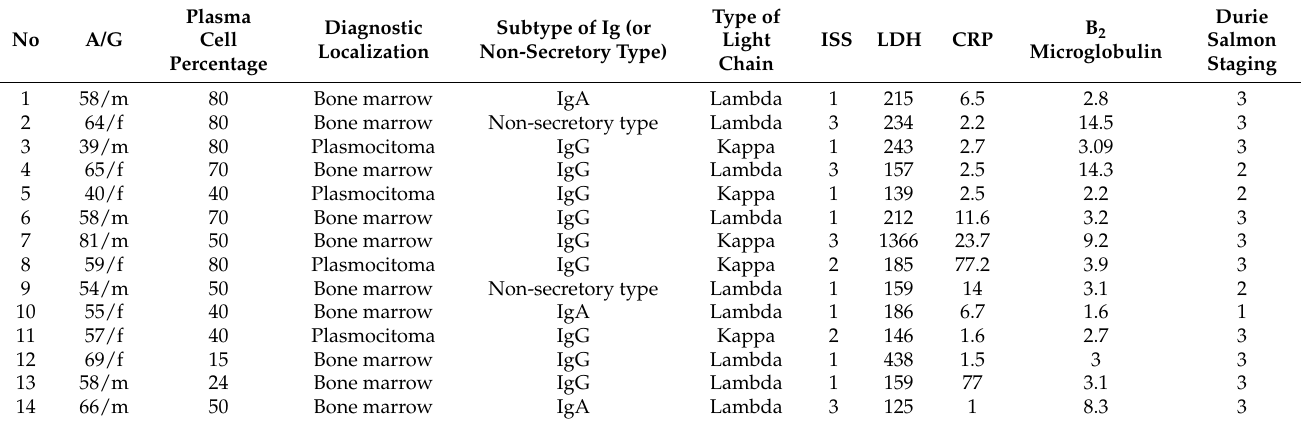
Table 1. Baseline characteristics of patients.